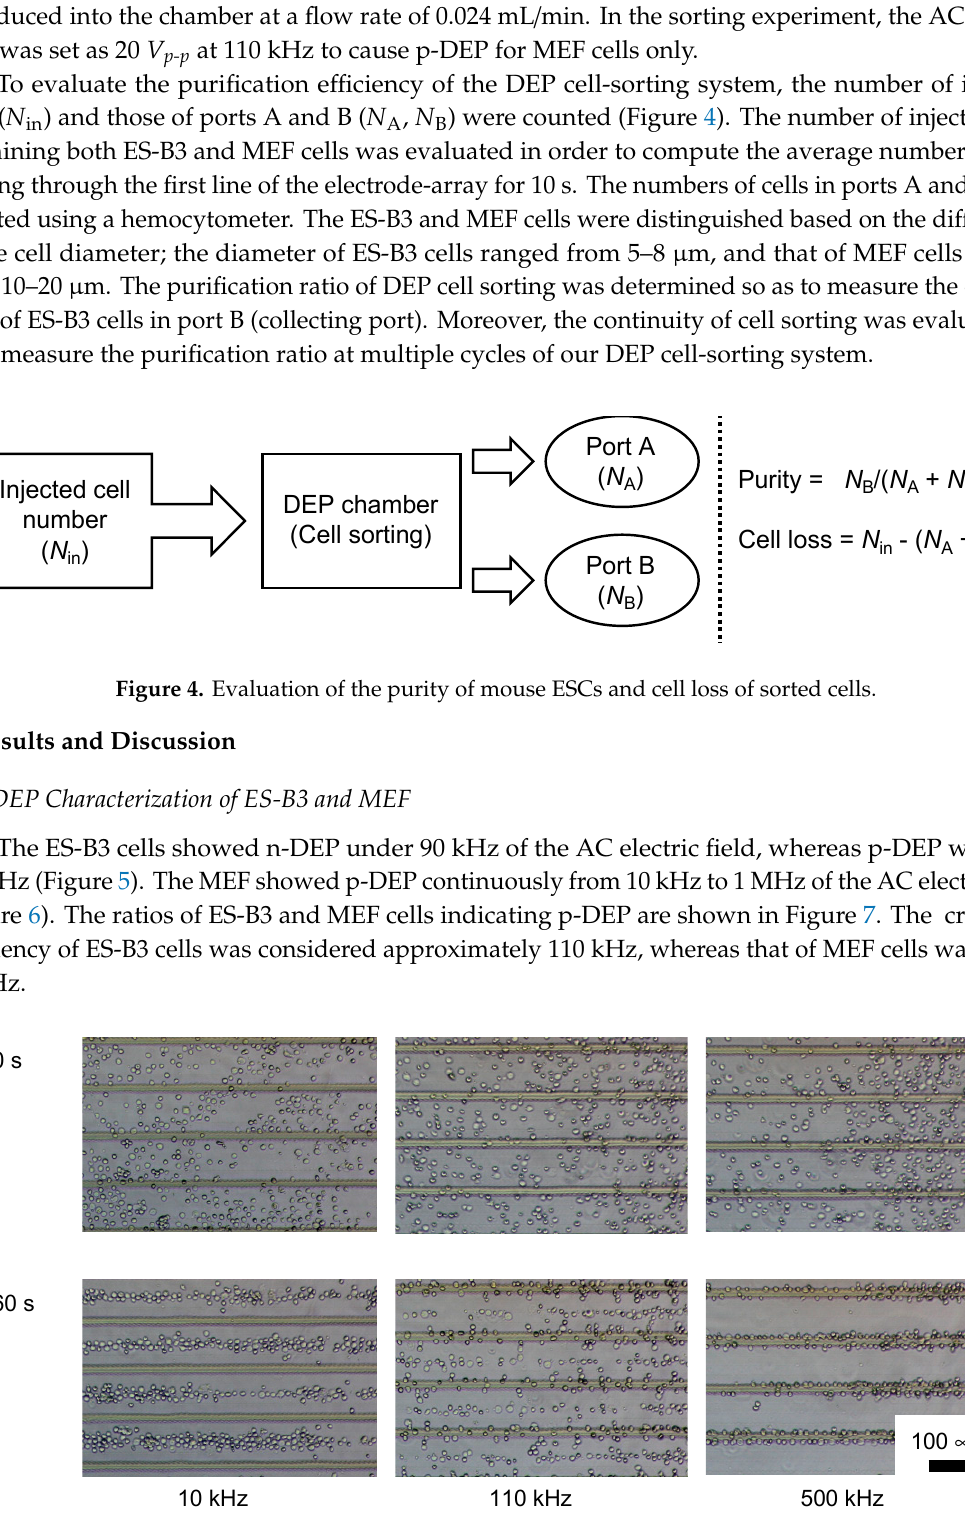
Figure 5. Dielectrophoresis of ES-B3 cells using a parallel line-electrode array before (0 s) and after (60 s) dielectrophoresis.